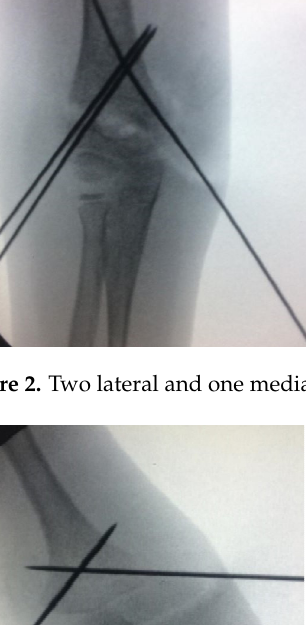
Figure 2. Two lateral and one medial pin con fi guration for supracondylar humeral fracture. Figure 4. Radiation duration and dose recorded via fl uoroscopy. All of the patients were discharged after 1 or 2 days and were seen in the clinic 1 week after surgery. Radiographs were obtained in both anteroposterior and lateral planes at this follow-up. If these were acceptable, the child was seen again after 3 weeks, the cast was removed, and radiographs were obtained again. When acceptable healing was con fi rmed, the pins were removed in the clinic, and motion was encouraged. The mean immobiliza- tion time with pins in the present study was 5.2 ± 1.24 (4–7) weeks. Only those patients with elbow sti ff ness were routinely treated with physiotherapy. Each patient was called for a control assessment every 3 months following pin re- moval. Clinical evaluation and radiographic evaluation were performed at each control visit. The clinical evaluation included the assessment of the carrying angle, the measure- ment of the passive range of elbow motion, a neurologic and vascular examination of the extremity, and the determination of any complications, such as super fi cial infection, deep infection, and the need for reoperation. The clinical results were graded according to the criteria of Flynn et al., which are based on the carrying angle and elbow motion [21]. The radiographic evaluation included an anteroposterior radiograph of the distal part of the humerus and a lateral radiograph of the elbow. A radiological assessment was made by comparing the Baumann angle, the humero-ulnar angle, and the humero-capitaller angle in the initial postoperative and fi nal follow-up radiographs [4,22]. A change in Baumann’s angle of more than 12° was de fi ned as a major loss of reduction, a change from 6° to 12° as mild displacement, and a change of less than 6° as no displacement. The data obtained in the study were analyzed statistically using SPSS v. 22.0 software (IBM Corp., Armonk, NY, USA). Pearson’s chi-square and Fisher’s exact tests were used to compare the categorical data to independently assess the relationships among sex, age, Flynn’s criteria, and type of fracture. The Mann–Whitney U-test was used to compare the mean values between the groups.